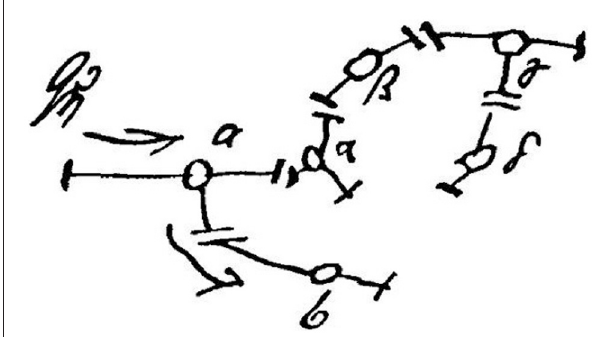
FIGURE 1 | Freud’s sketch of the neuronal mechanism of the mind. Freud proposed a neuronal mechanism of repression in 1895. This is the famous sketch of his idea. He forecasted the existence of the “synapse” in this sketch. According to his scheme of unpleasant memory, a stimulus (Q η ) normally activates unpleasant memory from neuron “a” to neuron “b”; however if other neurons (“ α ” and “ β ”) exert a “repressing” influence, such activation is prevented. Based on our microglia theory, the function of “Q η ” and/or “ α ” could be equivalent to a function of microglia as an energy source. Not only “repression” but also other unconscious functions, which were discovered by Freud and later psychoanalysts, may be modulated by